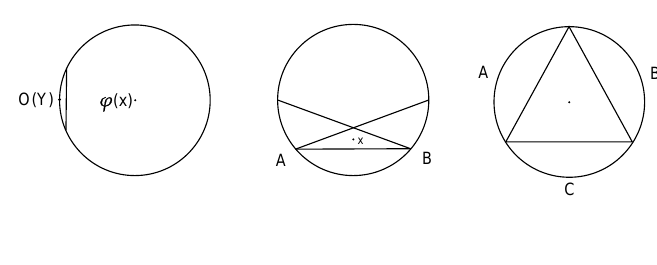
Figure 6: This figure should be compared to figure 3 in [ 21 ] .